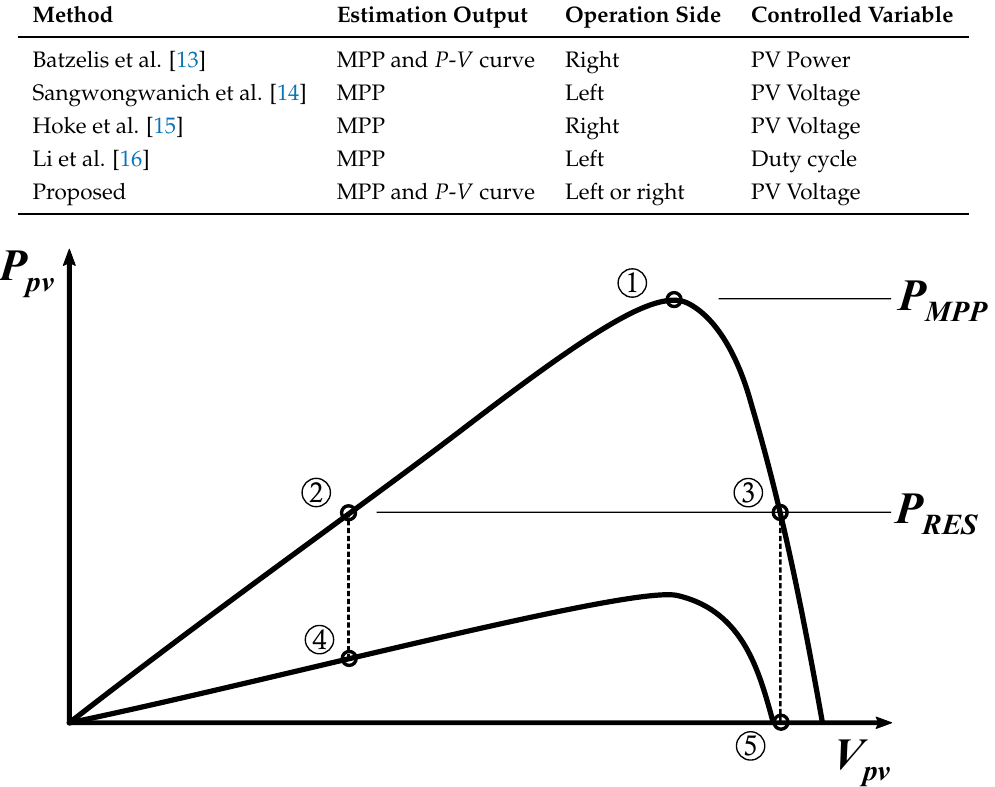
Figure 1. Stability analysis in case of fluctuating